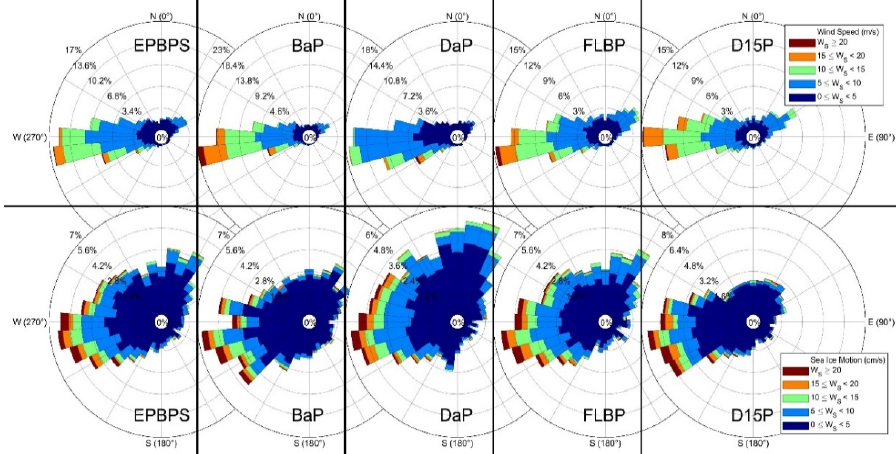
Figure 4. Rose diagrams of the daily wind (upper row) and sea ice motion vectors (lower row) for each polynya in eastern Prydz Bay. Each subfigure is labelled with the abbreviation of the polynya to which it refers. The legends of each row are presented on the right side of the row.